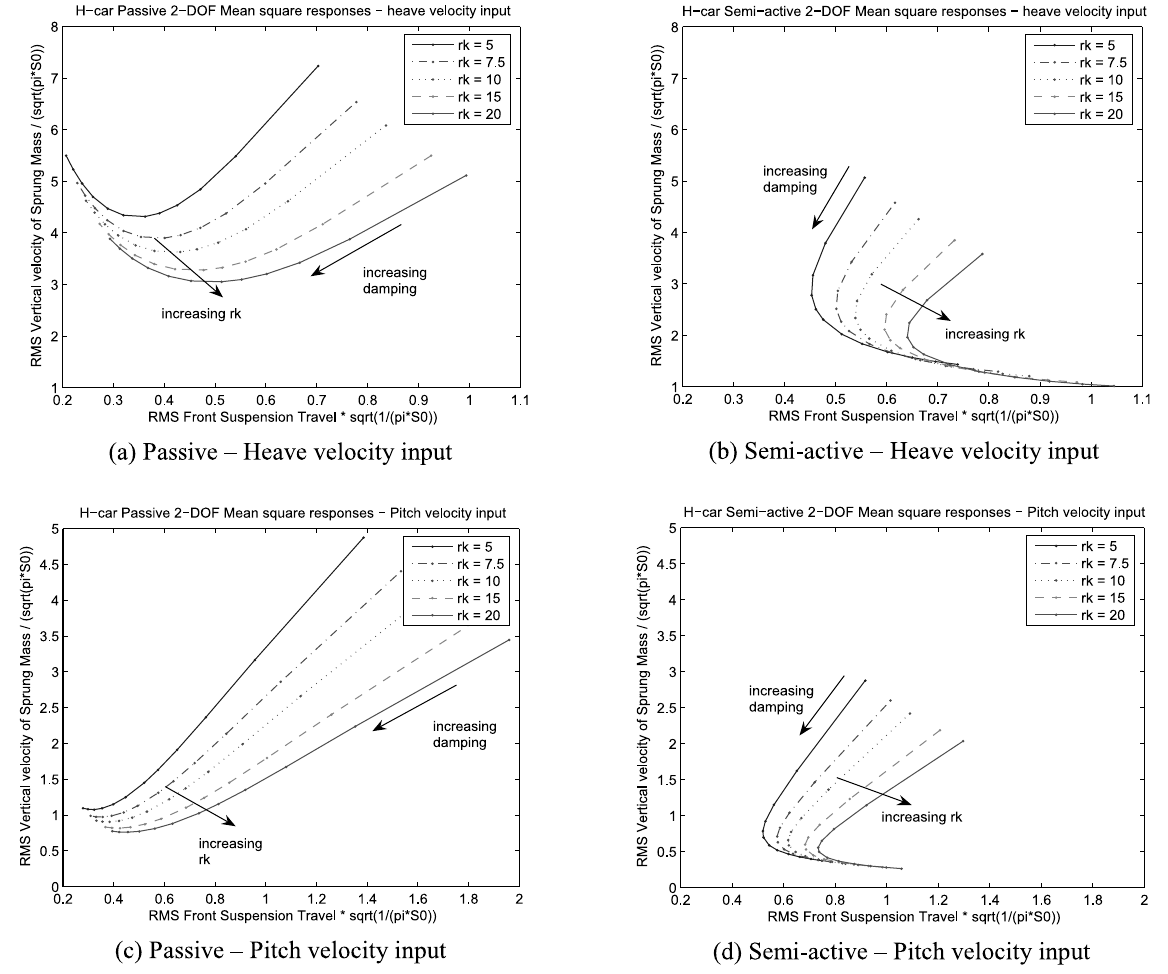
Fig. 9. Relationship between the rms vertical velocity to rms front suspension